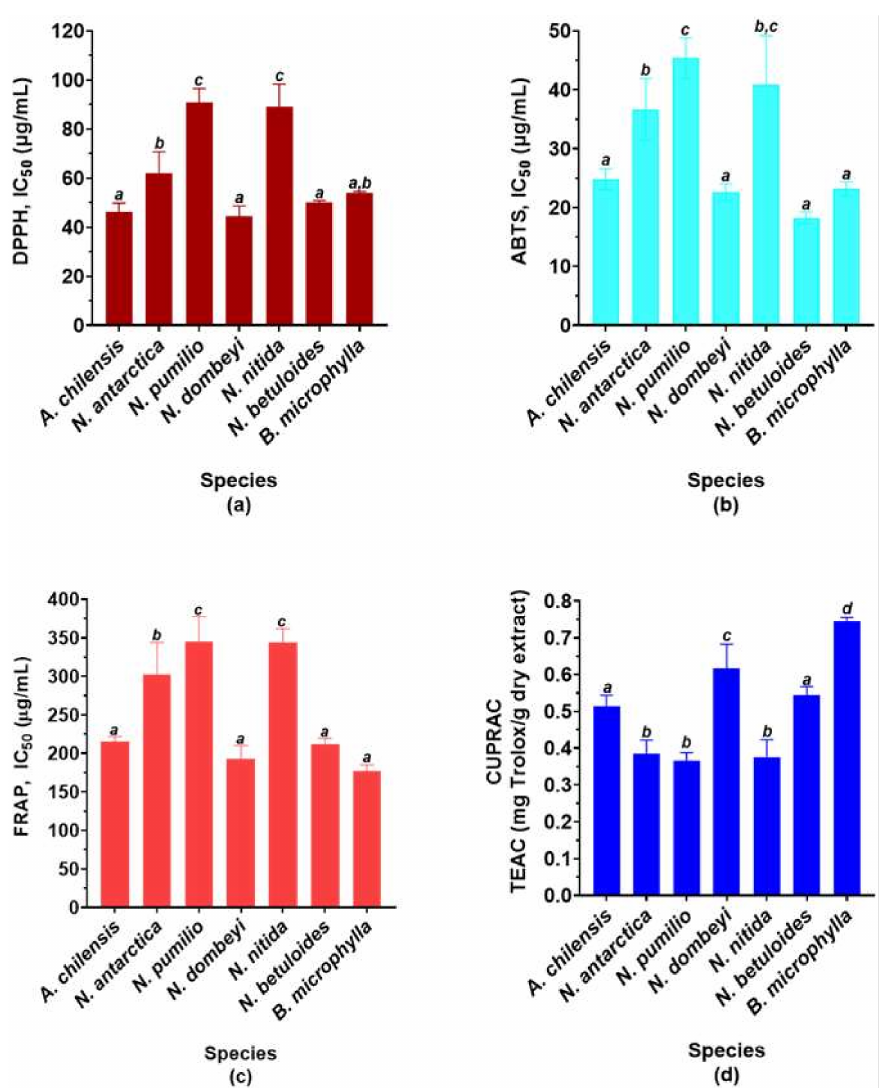
Figure 2. Antioxidant capacity of the studied species. Data are expressed as means ± SD (n = 9). ( a ) DPPH radical scavenging activity (IC 50 µ g/mL). ( b ) ABTS radical scavenging activ- ity (IC 50 µ g/mL). ( c ) FRAP (IC 50 µ g/mL). ( d ) CUPRAC expressed as equivalents of trolox (TEAC) per gram of dry extract. The different letters on the bars indicate significant differences with an average value of p < 0.05, Tuckey’s